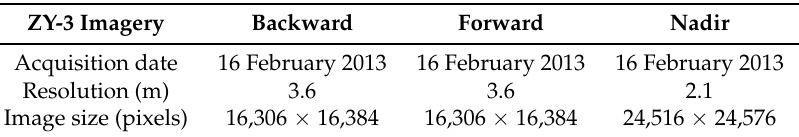
Figure 3. Four SPOT-5 images and the overlapping area : ( a ) Scene 01; ( b ) Scene 02; ( c ) Scene 03; ( d ) Scene 04; ( e ) The extents of four images and the distribution of GCPs. Table 2. Information about ZY-3 used in the